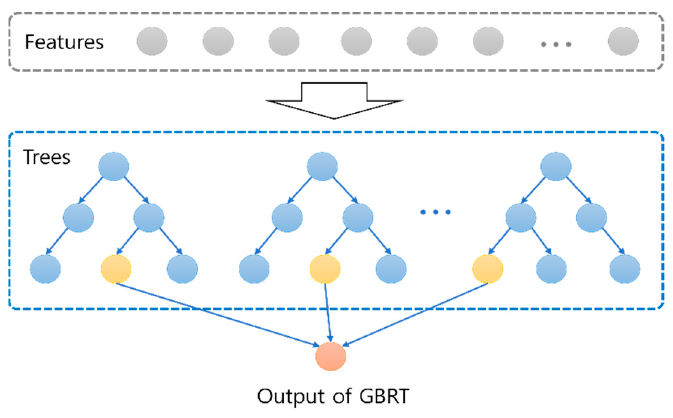
Figure 4. The structure of the GBRT model.